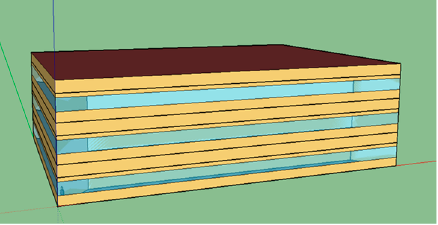
Figure 2. Simulation model in Energy plus.